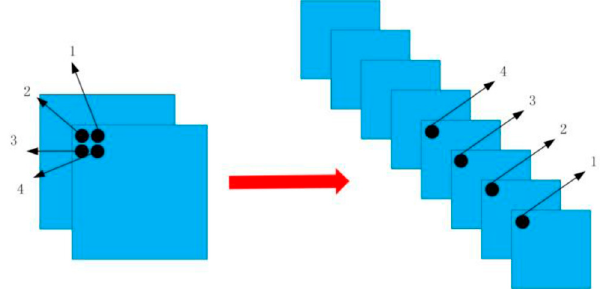
Figure 6. Passthrough-layer function: black circles with numbers indicate pixel in feature map before and after going through passthrough layer.